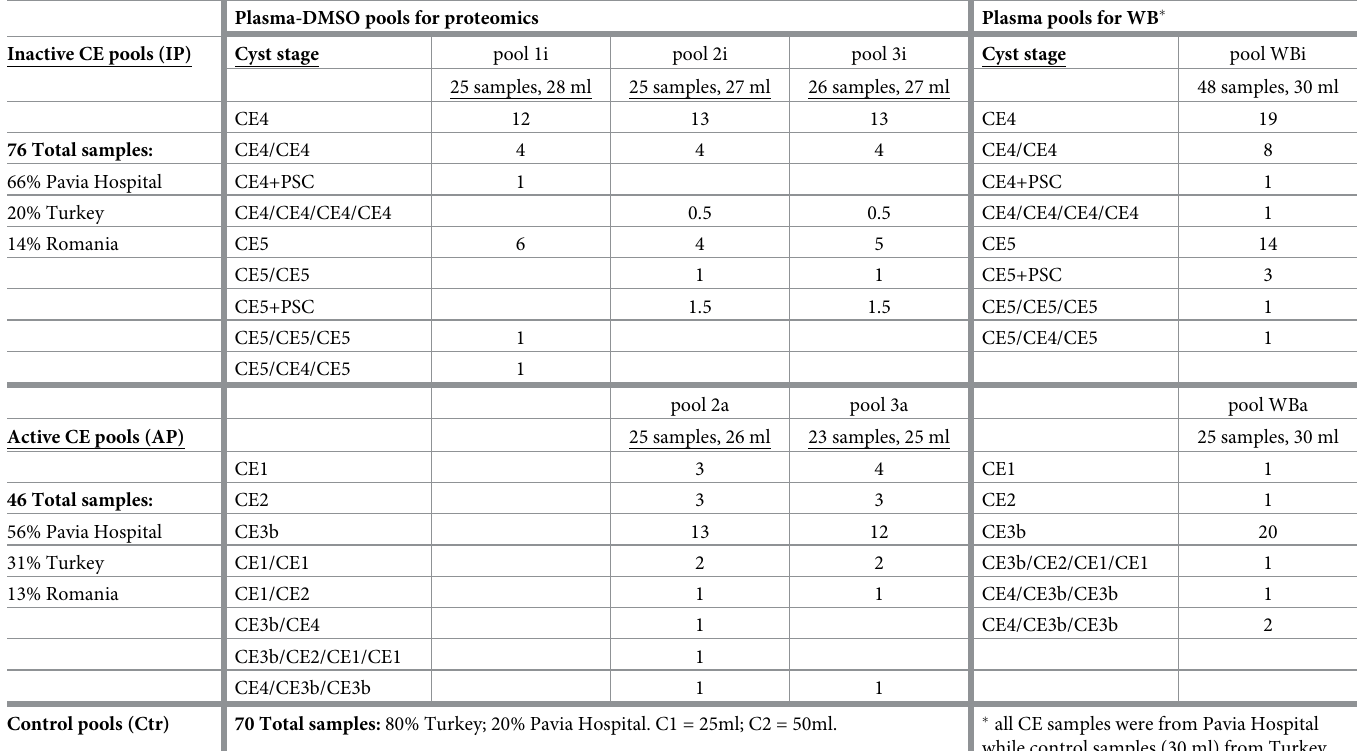
Table 1. Description of pool samples. Plasma-DMSO pools for